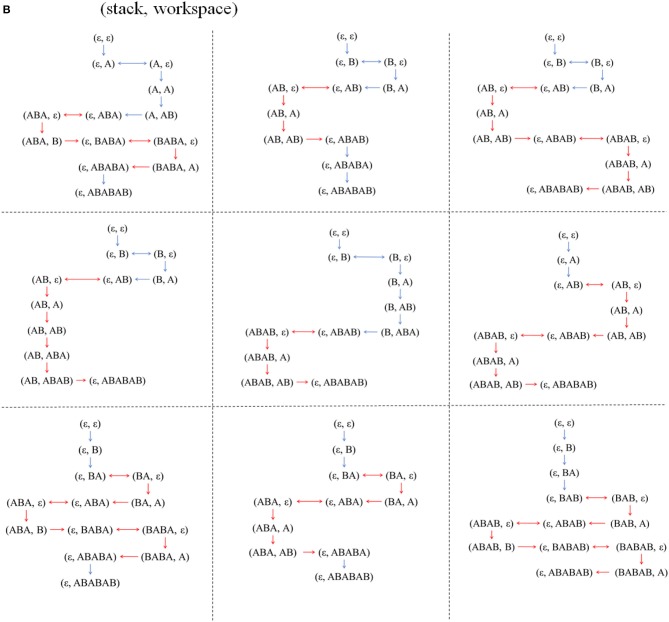
Examples (portion) of state transitions using the stack more than once to make a product ABABAB using non-RCs (blue arrows) and RCs (red arrows). The notation (x, y) means that x is the stack state and y is the workspace state. Vertical arrows represent Get actions, and horizontal arrows represent Push or Pop actions. The table has no particular order. In case of other product than ABABAB, the ratio of state transition using RC changes.